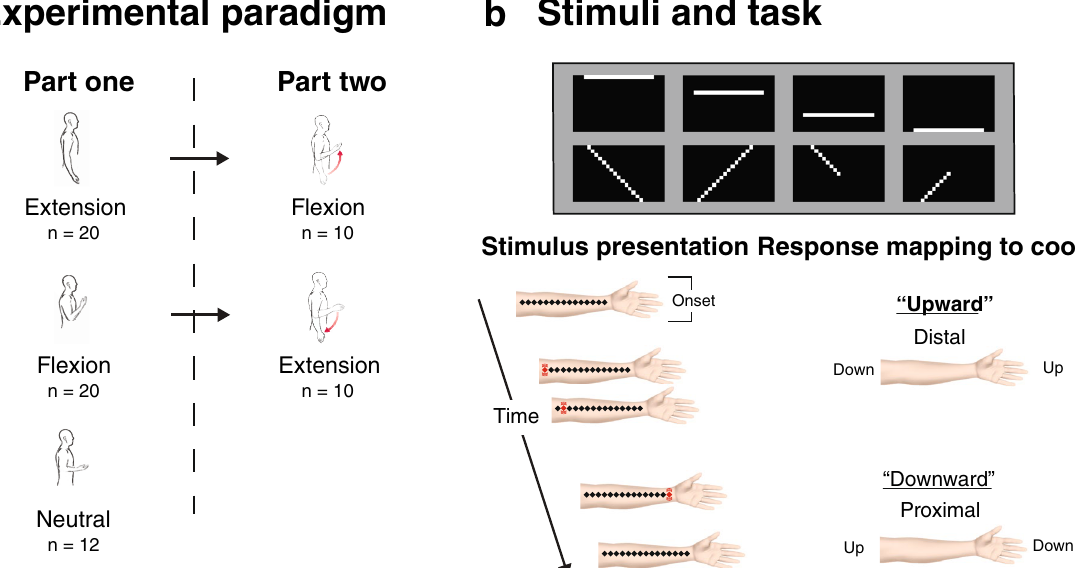
Figure 1. Experimental design and setup. ( a ) Participants (n = 52) were randomly allocated to one of three postures—Extension, Flexion, or Neutral. At the end of part one, 20 participants switched their posture from Flexion to Extension or vice versa. ( b ) Participants had to report the location or orientation of an image that included a diagonal or horizontal line, and which they did not see before. The images are set in opposite pairs, each flipped on the horizontal axis compared to its counterpart. A program temporally scans the 2D images from left to right and transforms each column into an array of evenly-spaced vibrotactile actuators that are on the inner arm. The stimulus presentation shows how an image of a diagonal line translates into a series of vibrations on the inner arm, time represents the x-axis and the physical location of the tactile sensation represents the y-axis (the red dot represents an active vibrator). An image of a horizontal line would result in the activation of a single vibrator, and the length of the line can be inferred from the vibration duration. The vertical orientation of the image is deliberately ambiguous and the line can be perceived as going up or down. We classified responses that matched tactile sensations closer to the wrist to the visual image’s upper bound as distal (“line is going up” in our example), and responses that fit the visual image’s upper bound as closer to the elbow as